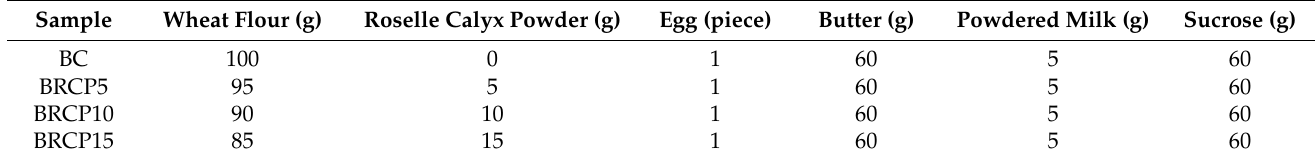
Table 1. Formulation of biscuits enriched with roselle calyx powder.